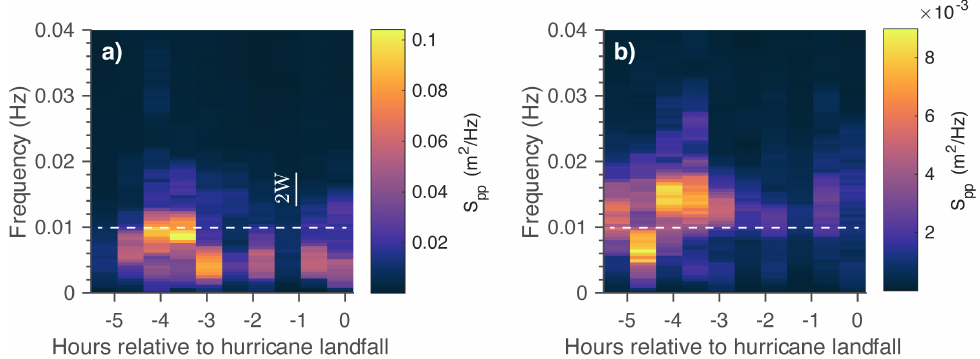
Figure 7. IG pressure head power spectra S pp in the ( a ) backshore and ( b ) back barrier during overwash at Matagorda Peninsula ( − 5 to 0 h), all obtained from ∼ 34 min records of the high-frequency pressure head ( f > 0.002 Hz). The time bandwidth of the ∼ 34 min multitaper spectral estimates is 5 with 9 Slepian tapers, yielding a 2 W of 0.0049 Hz and about 16 dof per frequency. The dashed lines partition the IG frequency band into low- and high-frequency